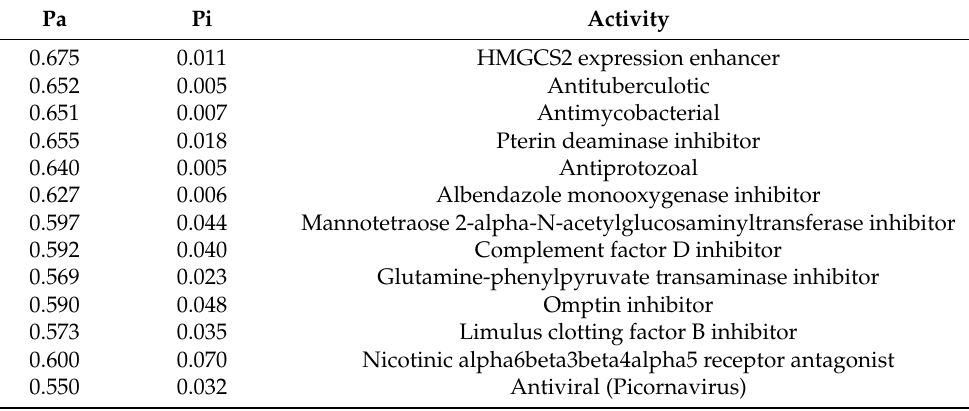
Table 2. Activity prediction results for the ligand. Pa (probability “to be active”); Pi (probability “to be